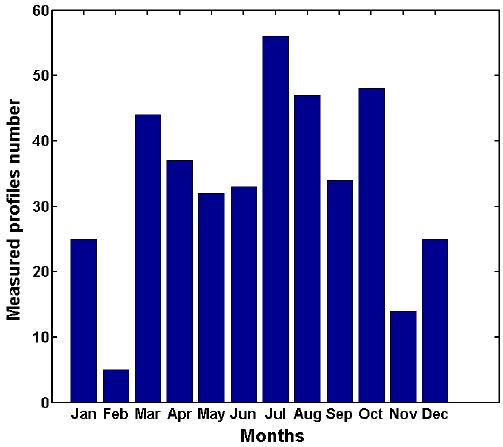
Fig. 5. Monthly distribution of water vapour profiles in